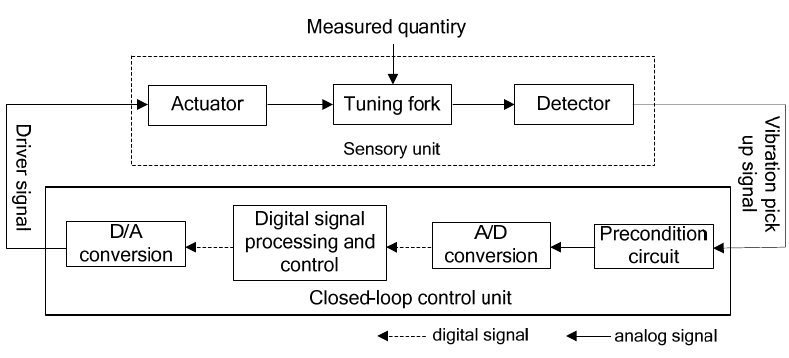
Figure 7. Block diagram of digital closed-loop control system.